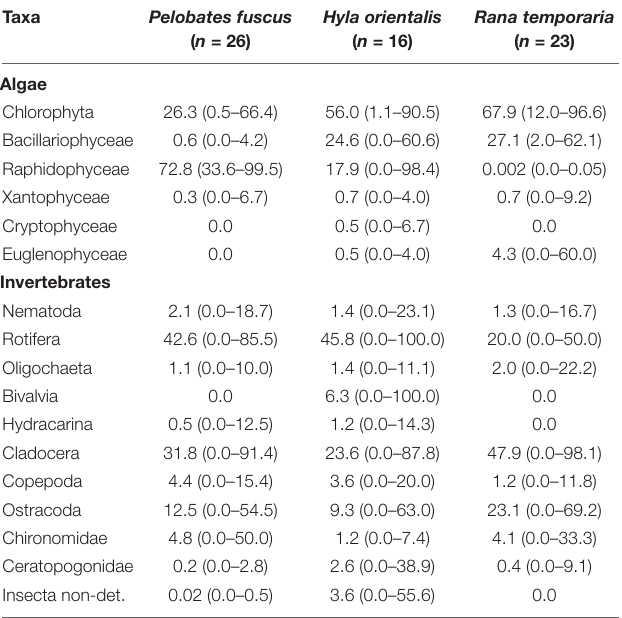
TABLE 2 | Diet composition of tadpoles of three anuran species, based on gut content analyses.